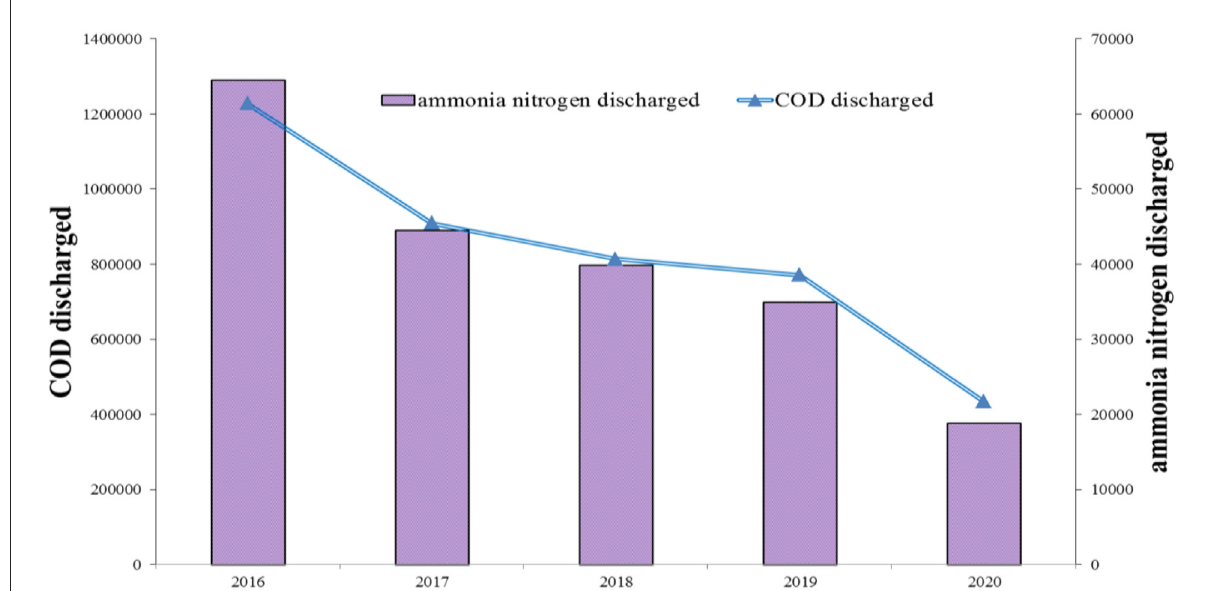
FIGURE1 Discharge of industrial wastewater in China during 2016–2020 (ton). Source: The author obtained the information from the China Statistical Yearbook on Environment .